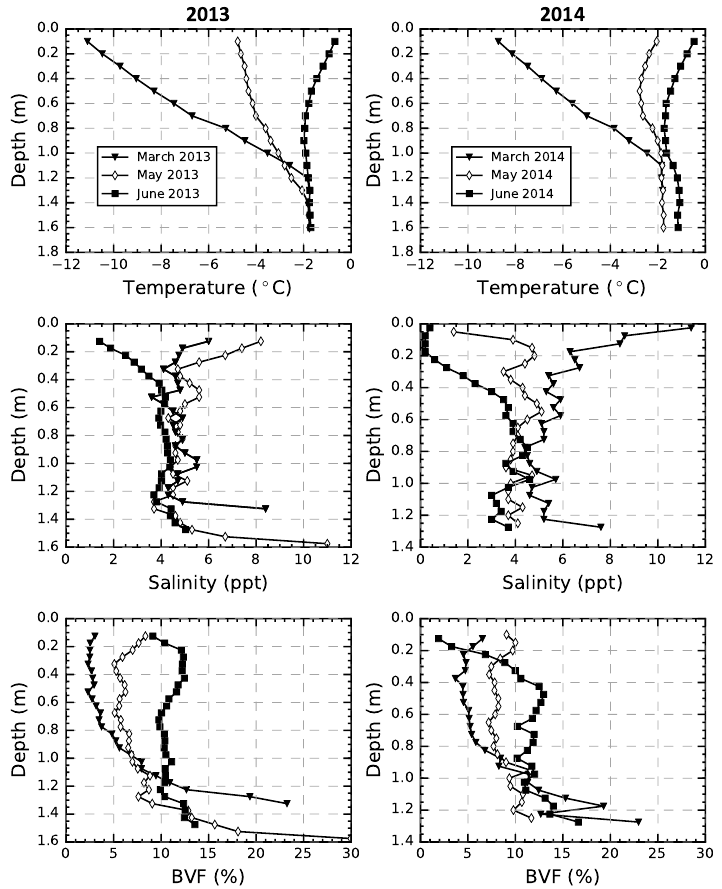
Figure 4. Temperature, salinity, and brine volume fraction profiles for spring of 2013 and 2014. March values shown as closed triangles, May values as open diamonds, and June values as closed